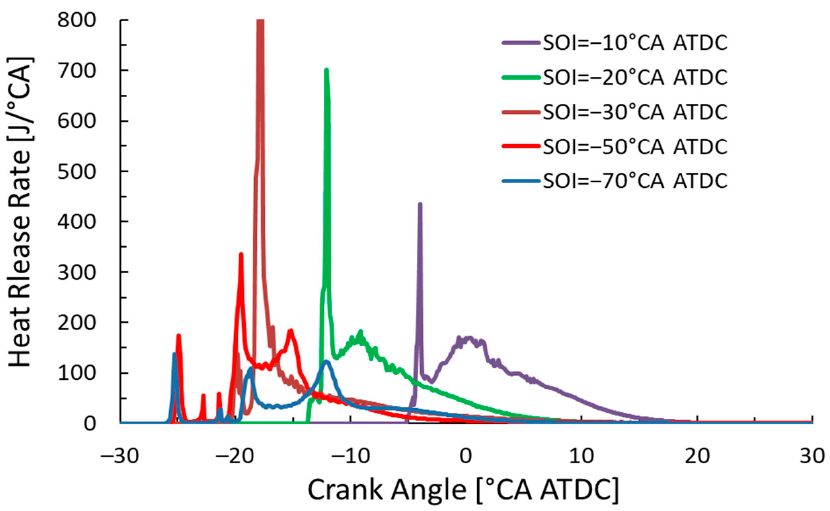
Figure 9. AHRR histories for a variety of SOI